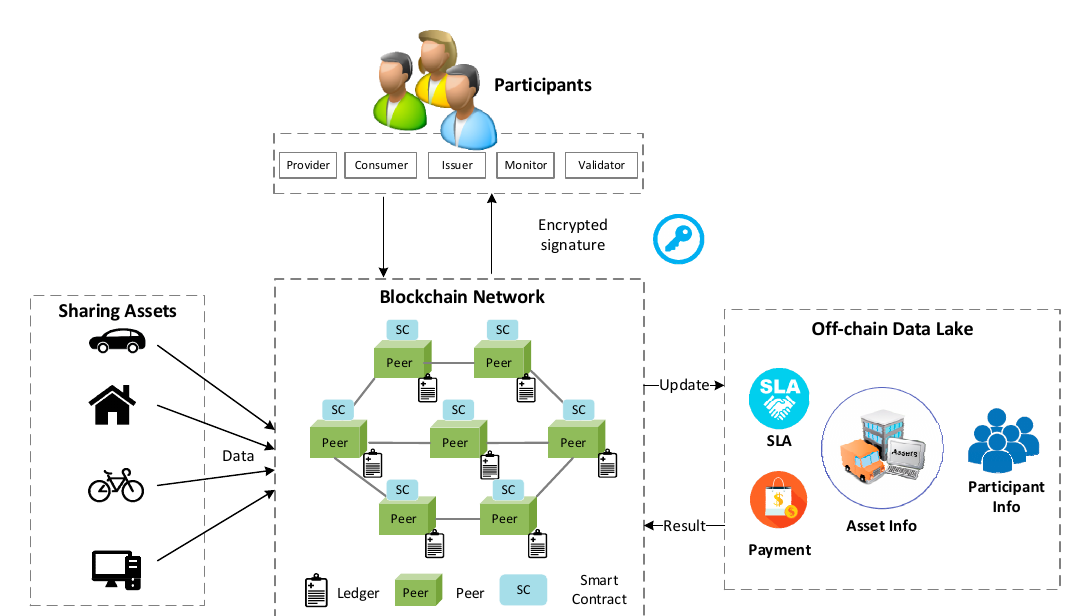
Figure 1. Conceptual model of the service level agreement (SLA)-based sharing economy service with the smart contract.